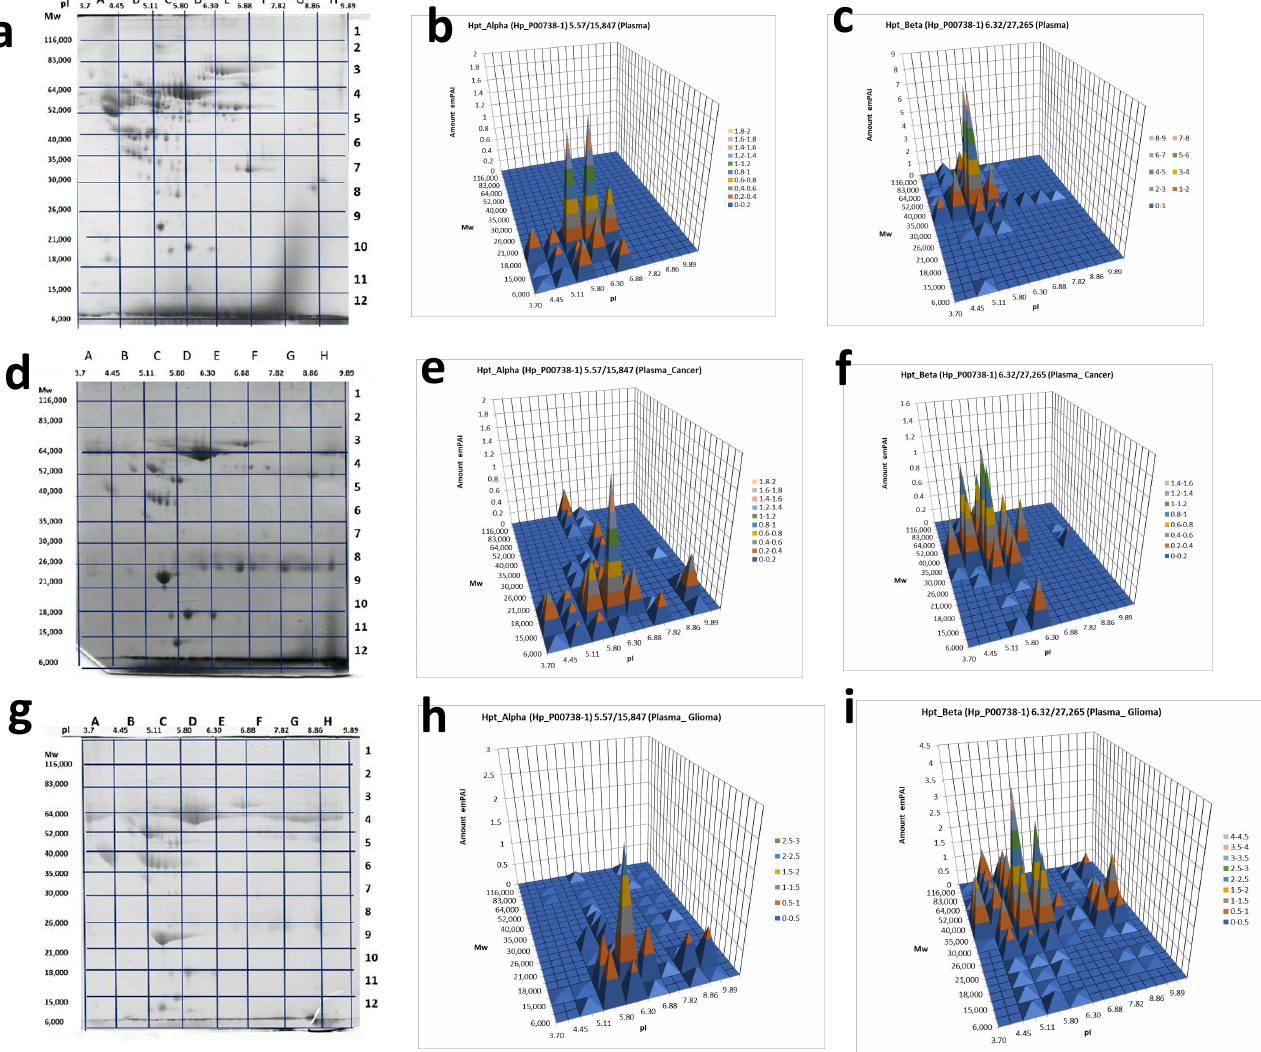
Figure 5. 2DE sectional analysis of Hp proteoforms in plasma. (From left to right) Sections in 2DE gel selected for the following ESI LC − MS/MS analysis, Hp α -chain or β -chain detection in sections: ( a – c ) control, a pooled plasma of the mix of samples from 54 healthy donors [31], ( d – f ) a patient with colon cancer, and ( g – i ) a GBM